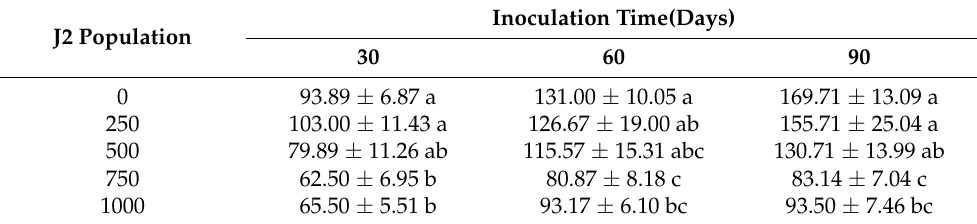
Table 2. Plant height growth rate of rice in the second experiment